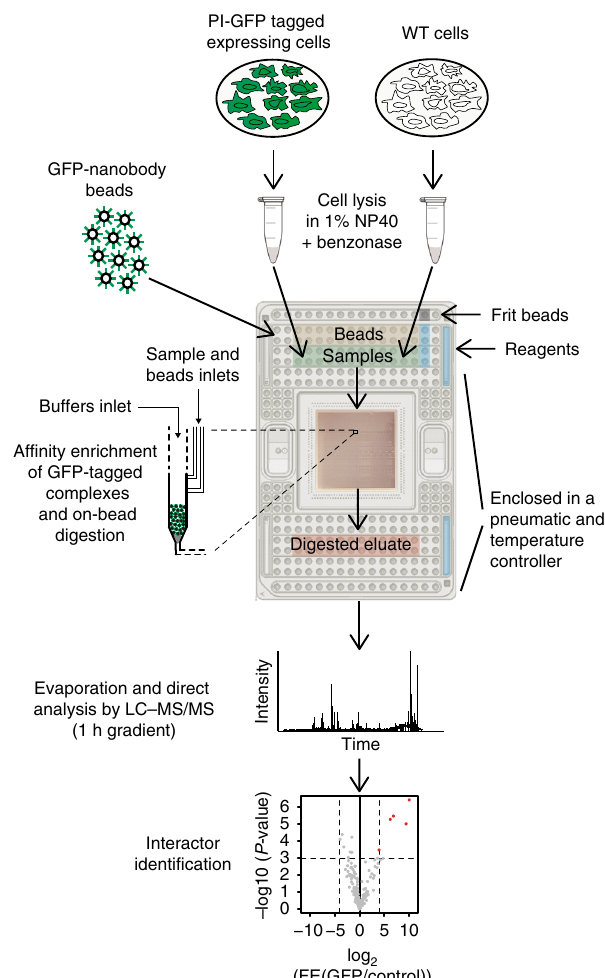
Fig. 1 Work fl ow for af fi nity puri fi cation of GFP-tagged complexes on a micro fl uidic device. A limited number of cells (in this paper we used 12,000 cells for proof-of-principle) expressing a GFP-tagged form of a protein of interest (PI) are lysed to obtain whole cell extracts that serve as pools of proteins. Test samples as well as the appropriate controls are loaded into a micro fl uidic chip which is preloaded with all buffers and reagents that